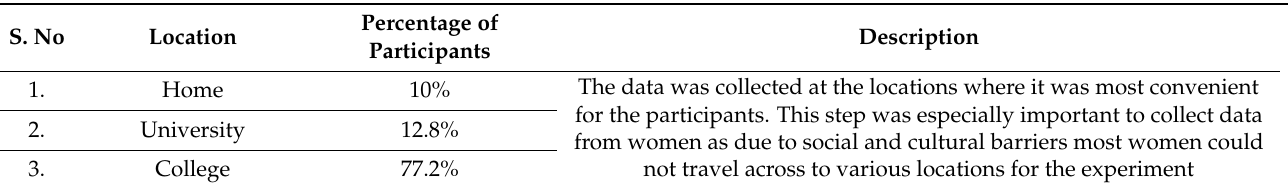
Table 2. Data collected at various locations per participants’